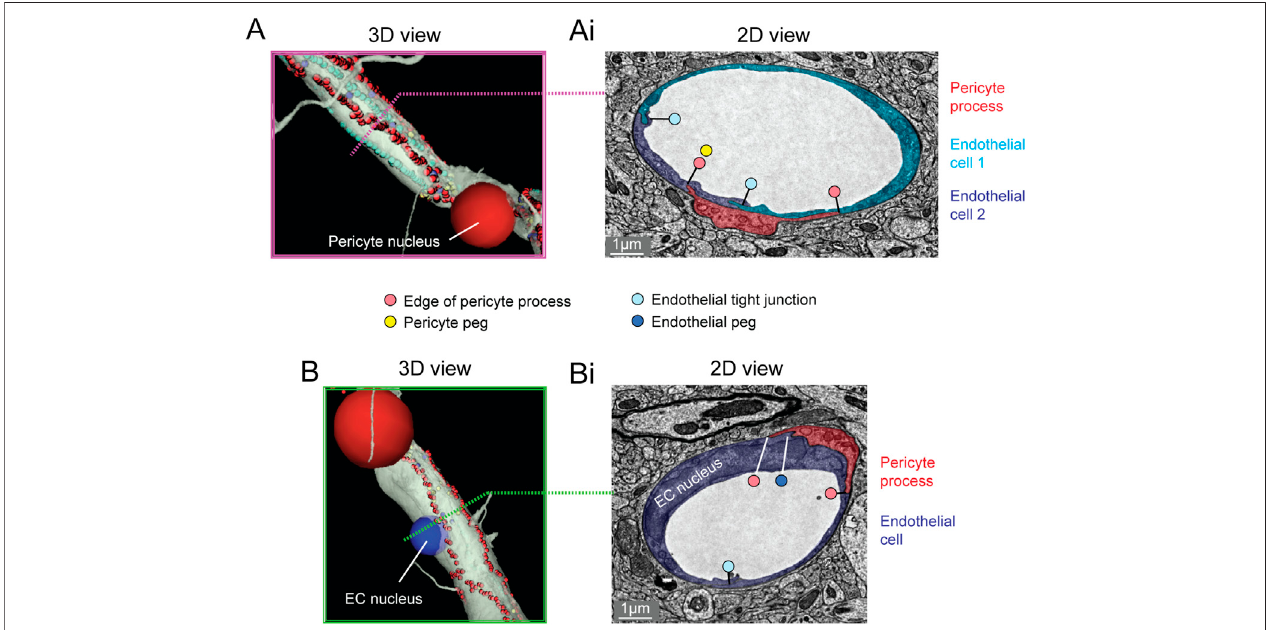
FIGURE 3 | Pericyte processes in relation to endothelial features. (A) The edge of a pericyte process annotated in Neuroglancer 3D view with red dots, alongside endothelial junctions in cyan dots. (Ai) The 2D cross section of one location (dotted magenta line) within the same capillary segment. (B) The pericyte process tends to exhibit greater endothelial coverage near endothelial somata. (Bi) The 2D cross section of one location (dotted green line) within the same capillary segment. EC, endothelial cell. Images adapted from (Ornelas et al., 2021). Link to annotations (See methods to register and agree to terms of service): https://neuromancer-